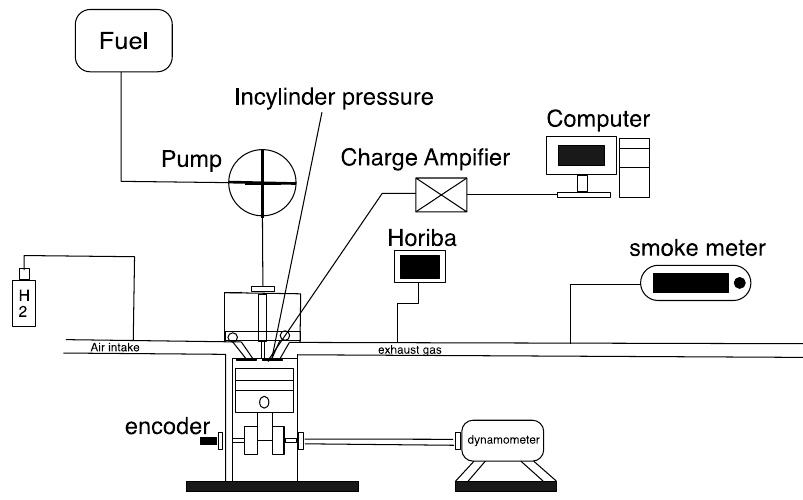
Figure 1. The experimental setup. Table 2. Engine Specifications.